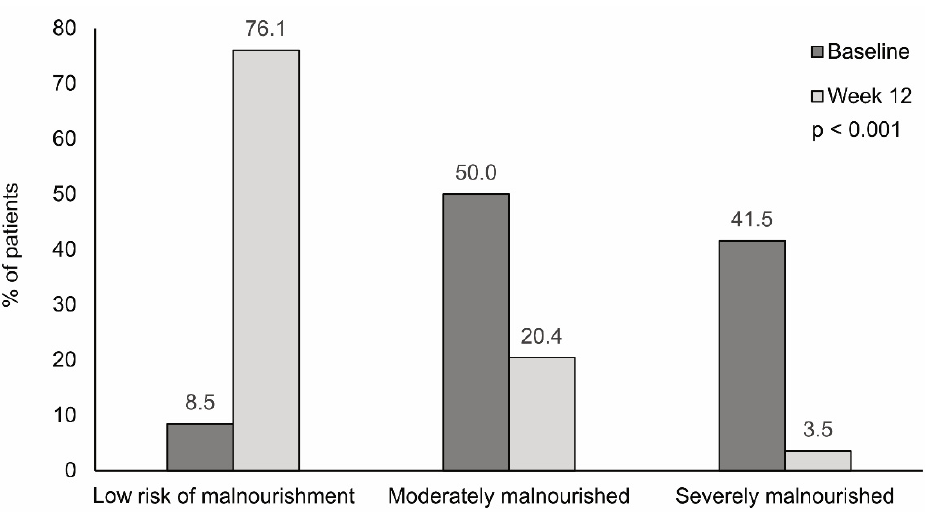
Figure 1. Change in nutritional status after 12 weeks of treatment with a semi-elemental hydrolyzed whey protein diet. The bar graph shows the proportion of patients at low risk of malnourishment and with moderate or severe malnourishment at baseline and after 12 weeks. The change in the nutritional status was statistically significant ( p < 0.001).